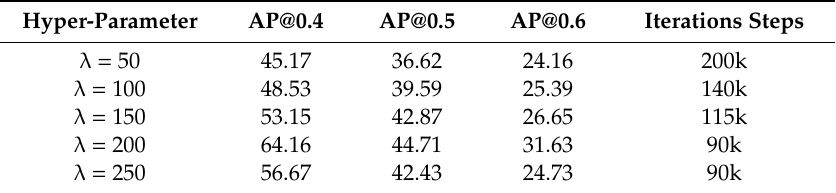
Table 7. E ff ect of hyper-parameter value on precision and convergence speed of PYolo (%).